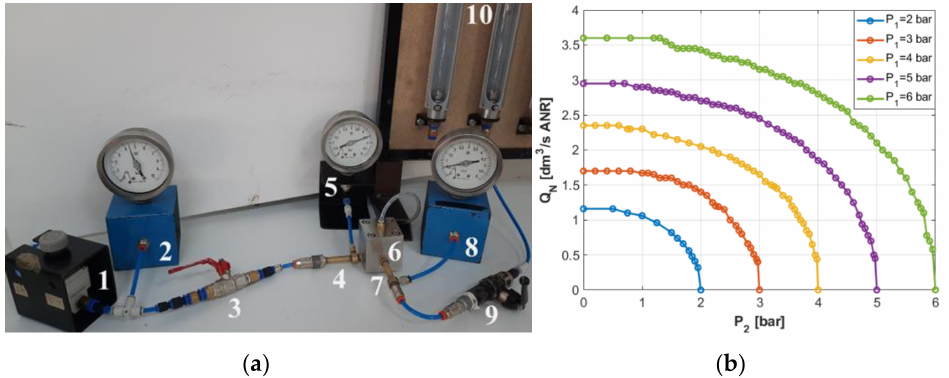
Figure 11. Flow rate characteristics of the 2/2 valve. ( a ) Test bed and its components: (1) adjustable pressure regulator, (2) pressure gauge, (3) shut-off valve, (4) upstream pressure-measurement tube, (5) upstream P 1 pressure gauge, (6) valve under test, (7) downstream pressure-measurement tube, (8) downstream P 2 pressure gauge, (9) flow control valve, (10) asameters. ( b ) Volume flow rate curves for different values of P 1